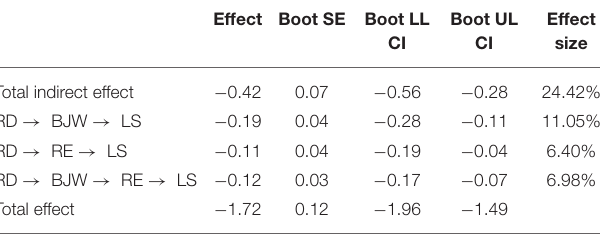
TABLE 3 | Indirect effects of relative deprivation on life